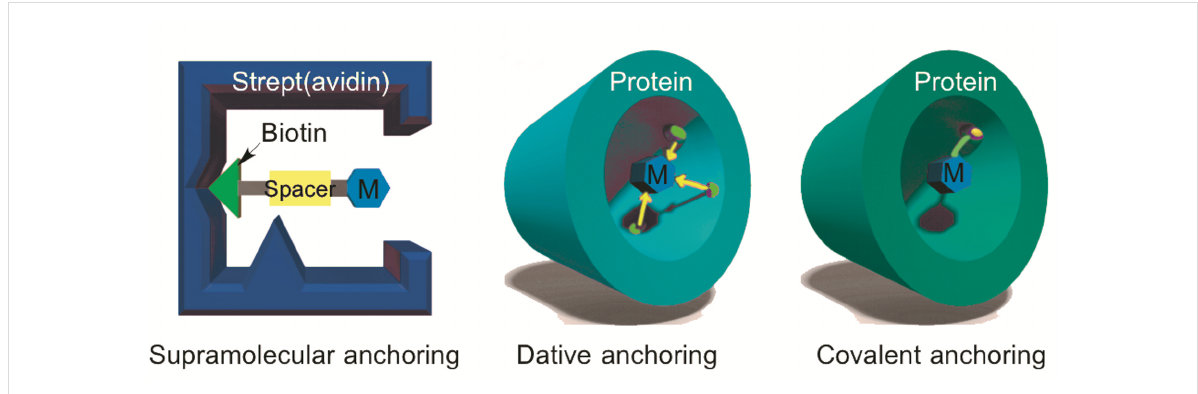
Figure 1: Common anchoring strategies for metal-complex or metal ion incorporation into protein scaffolds.